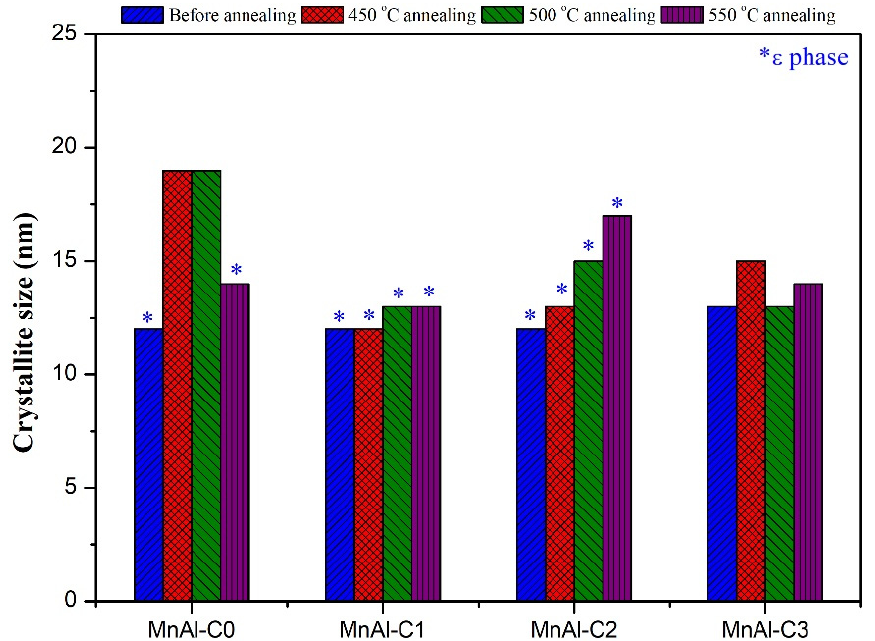
Figure 2. Crystallite size of the main τ or ε phase in (Mn 55 Al 45 ) 100-x C x powders before and after annealing for 20 min at 450, 500, 550 °C under argon atmosphere.